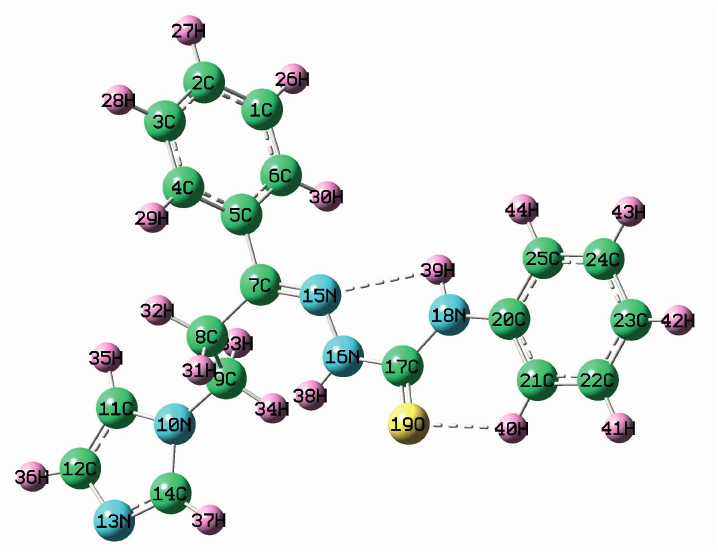
Figure 3. Optimized molecular structure of (2 E